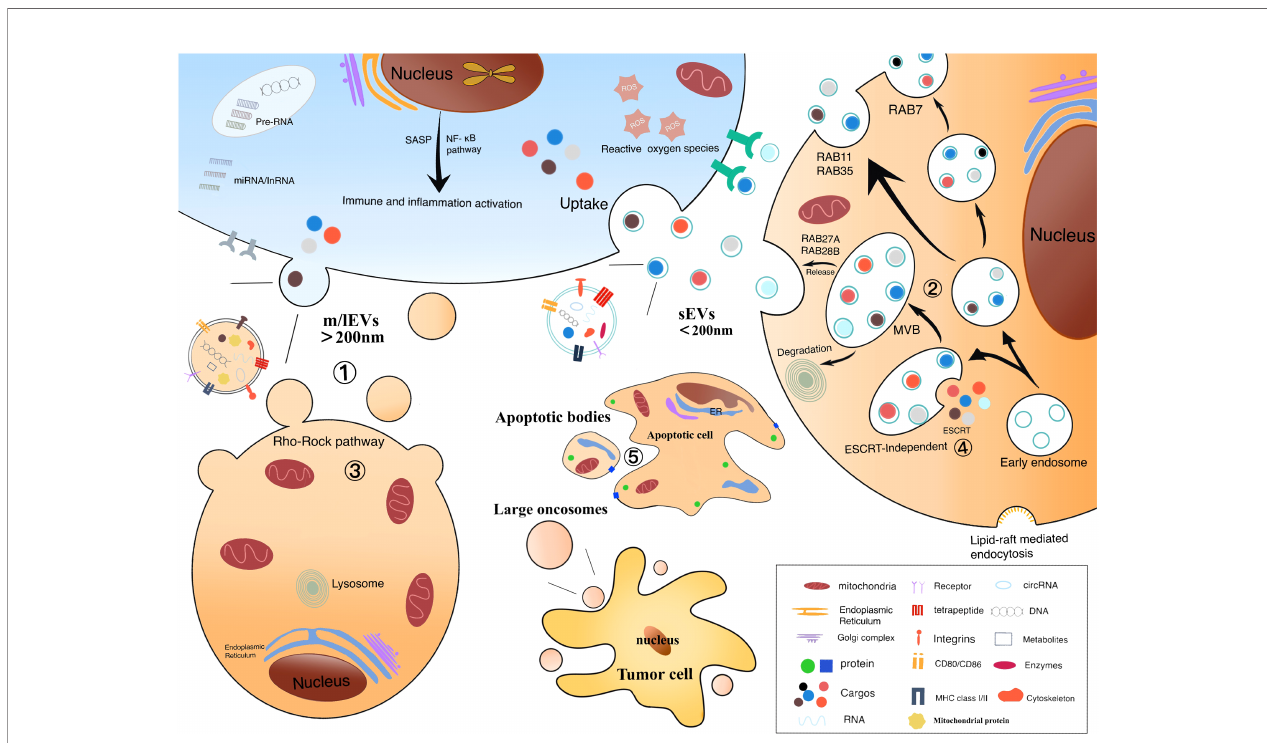
FIGURE 1 | Biological origin of electric vehicles: ① m/lEV formation is the result of mass membrane foaming. Calcium relies on the cellular scale of protein hydrolysis degrading membrane binding, which can help cell membranes germinate and promote their secretion. ② Formation of sEV includes endocytosis, the formation of nucleosomes and MVBs, and the release of sEVs. The vesicles contained in MVBs fuse with the plasma membrane, causing their release. ③ Refactoring is related to the Rho/Rock pathway. ④ Composition of ESCRT is related to the biological occurrence of sEV and MVB. Rab protein facilitates the transport and docking of MVBs over the plasma membrane, leading to cytoplasmic vomiting and the release of sEVs. ⑤ Extensive membrane vesicles occur on the membrane of apoptotic cells to form apoptotic